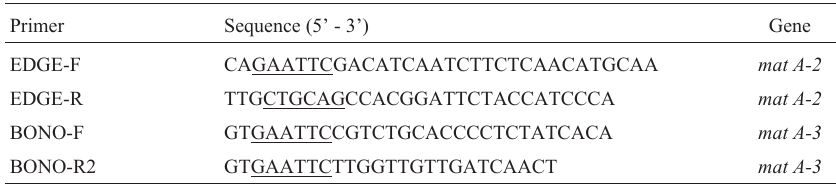
Table 1 - Sequences of mat A-2 and mat A-3 primers used in this